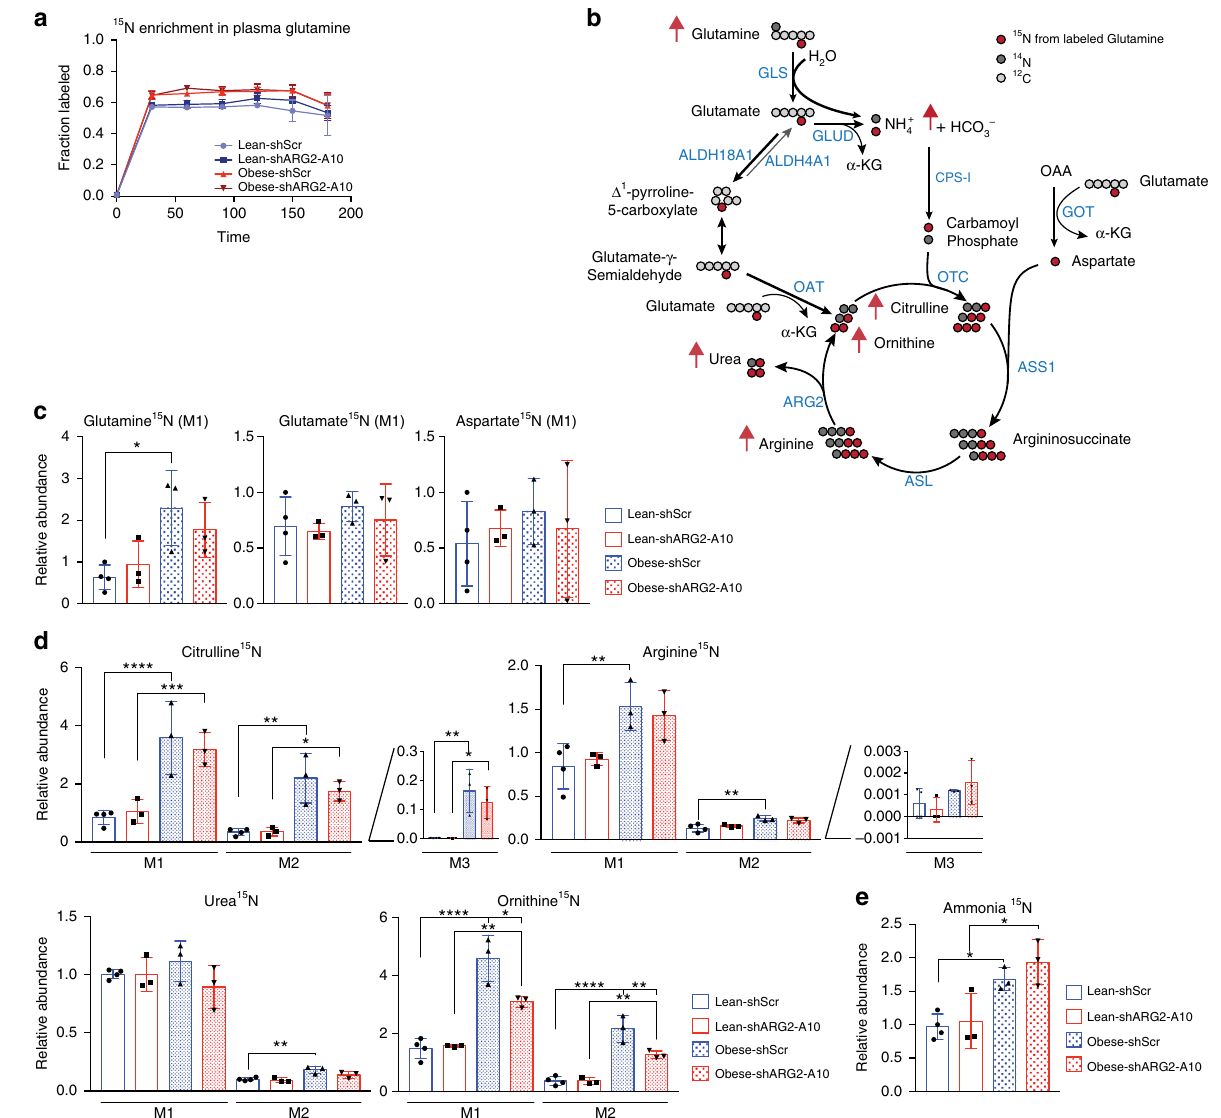
Fig. 4 PDA tumors of the obese have enhanced nitrogen fl ux into the urea cycle. a 15 N enrichment in plasma glutamine in 19 – 21 week old male Rag1 − / − mice bearing orthotopic AsPC1-shScr and AspC1-shARG2 PDA tumors that were infused with 15 N(amine) glutamine ( n = 3). b Schematic of the urea cycle with red arrows indicating increases in 15 N-labeling of the urea cycle metabolites in tumors of the obese; CPS-1, Carbamoyl phosphate synthase 1; OTC, Ornithine transcarbamylase; ASL, Argininosuccinate lyase. c , d Relative abundance of 15 N-labeled metabolites ( n = 3 except for Lean-shScr n = 4) outside c , or within d the urea cycle. e Relative abundance of derivatized 15 N-ammonia. Data indicate the mean ± s.d. in a , c – e , and are representative of two independent experiments. * P ≤ 0.05, ** P ≤ 0.01, *** P ≤ 0.001, **** P ≤ 0.0001, by one-way ANOVA followed by Tukey